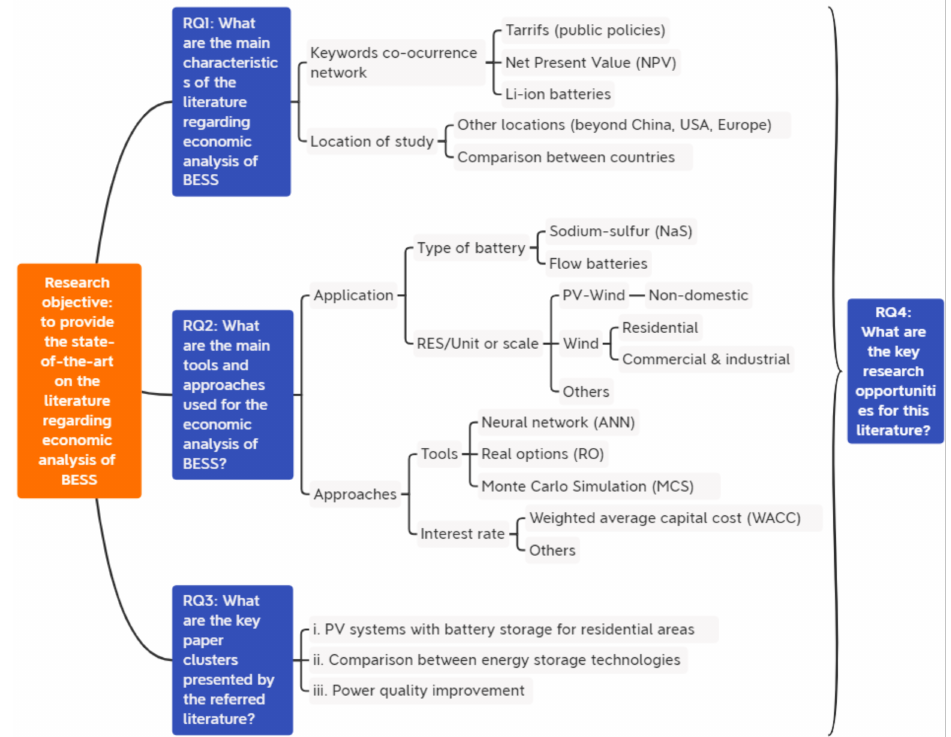
Figure 11. Research